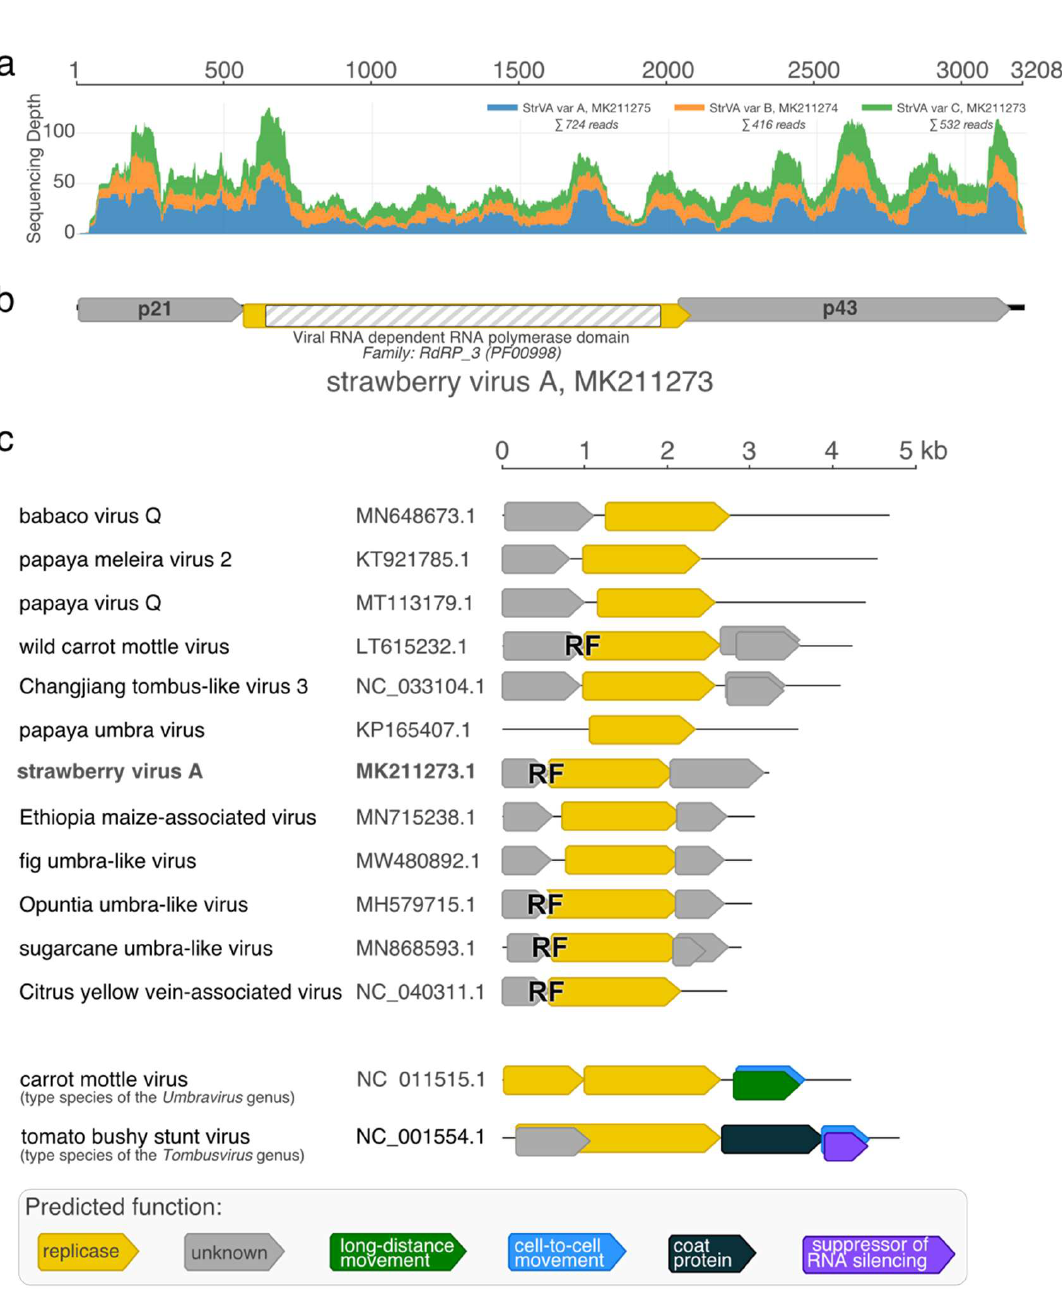
Figure 1. Sequencing coverage ( a ), genomic organization of strawberry virus A (StrVA) ( b ), and StrVA-related viruses ( c ). RF stands for predicted −1 ribosomal frameshifting.